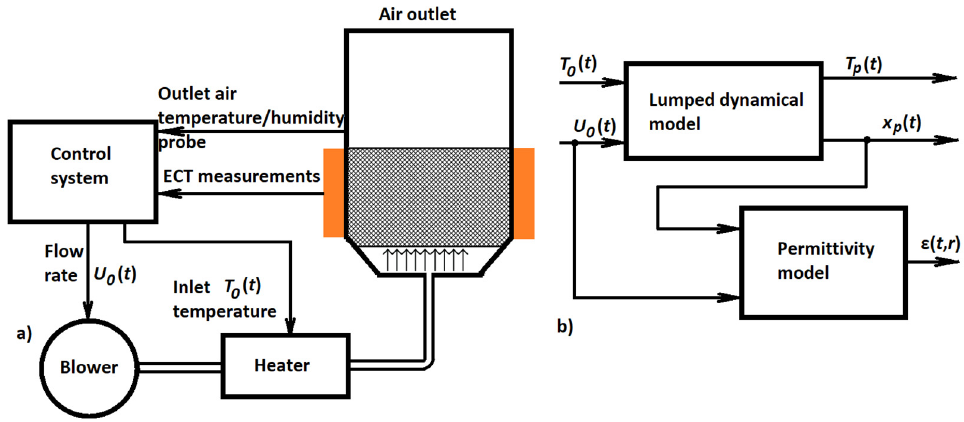
Figure 5 . ( a ) Schematic sketch of the fluidized bed dryer and its instrumentation ( b ) structure of its control-oriented mathematical model. control-oriented mathematical